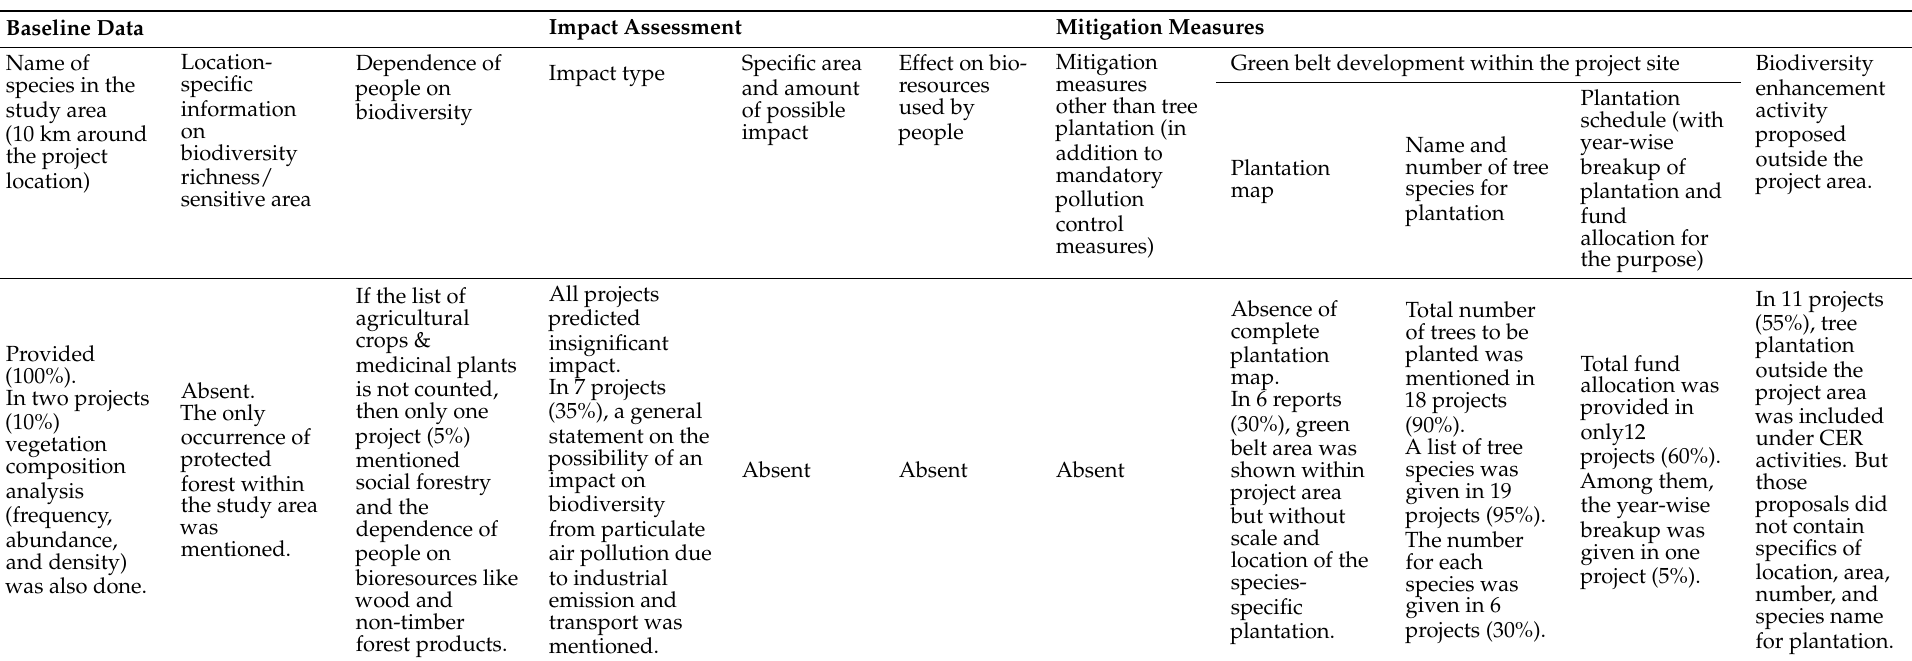
Table 1. Presence or absence of basic information on baseline data, impact assessment, and mitigation measures regarding biodiversity in the 20 EIA reports studied. Figure within bracket is the % of projects in which different items